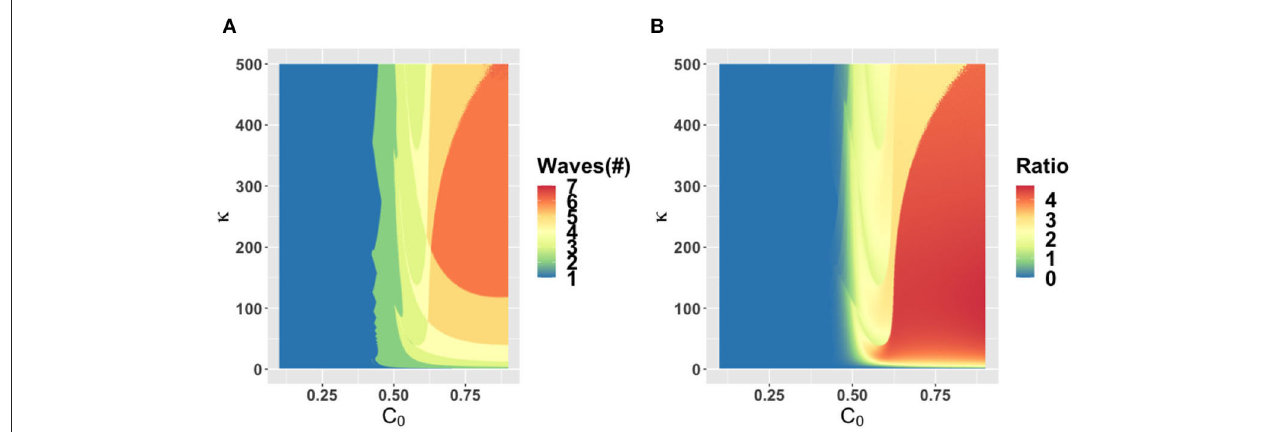
FIGURE 5 | Parameter plane showing model dynamics as they vary with changes in the rate κ that controls the social learning rate and the parameter C 0 which controls how effective closure is, for the number of COVID-19 waves (A) and the ratio of peak height of the second wave to the first wave peak (B) . Other parameters are at baseline values ( Table 1